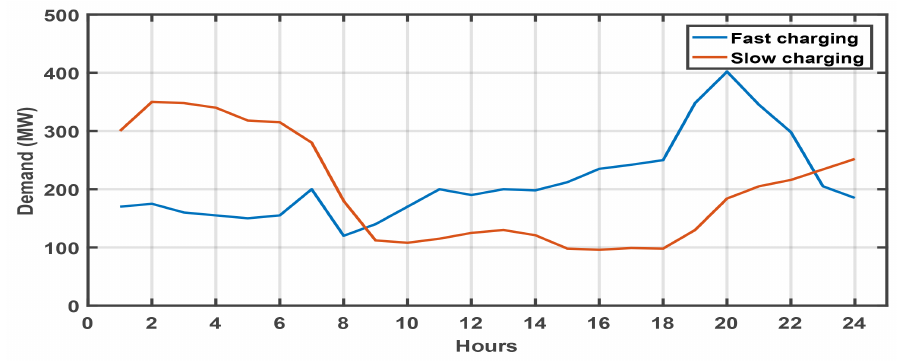
Figure 5. EV demand according to charging